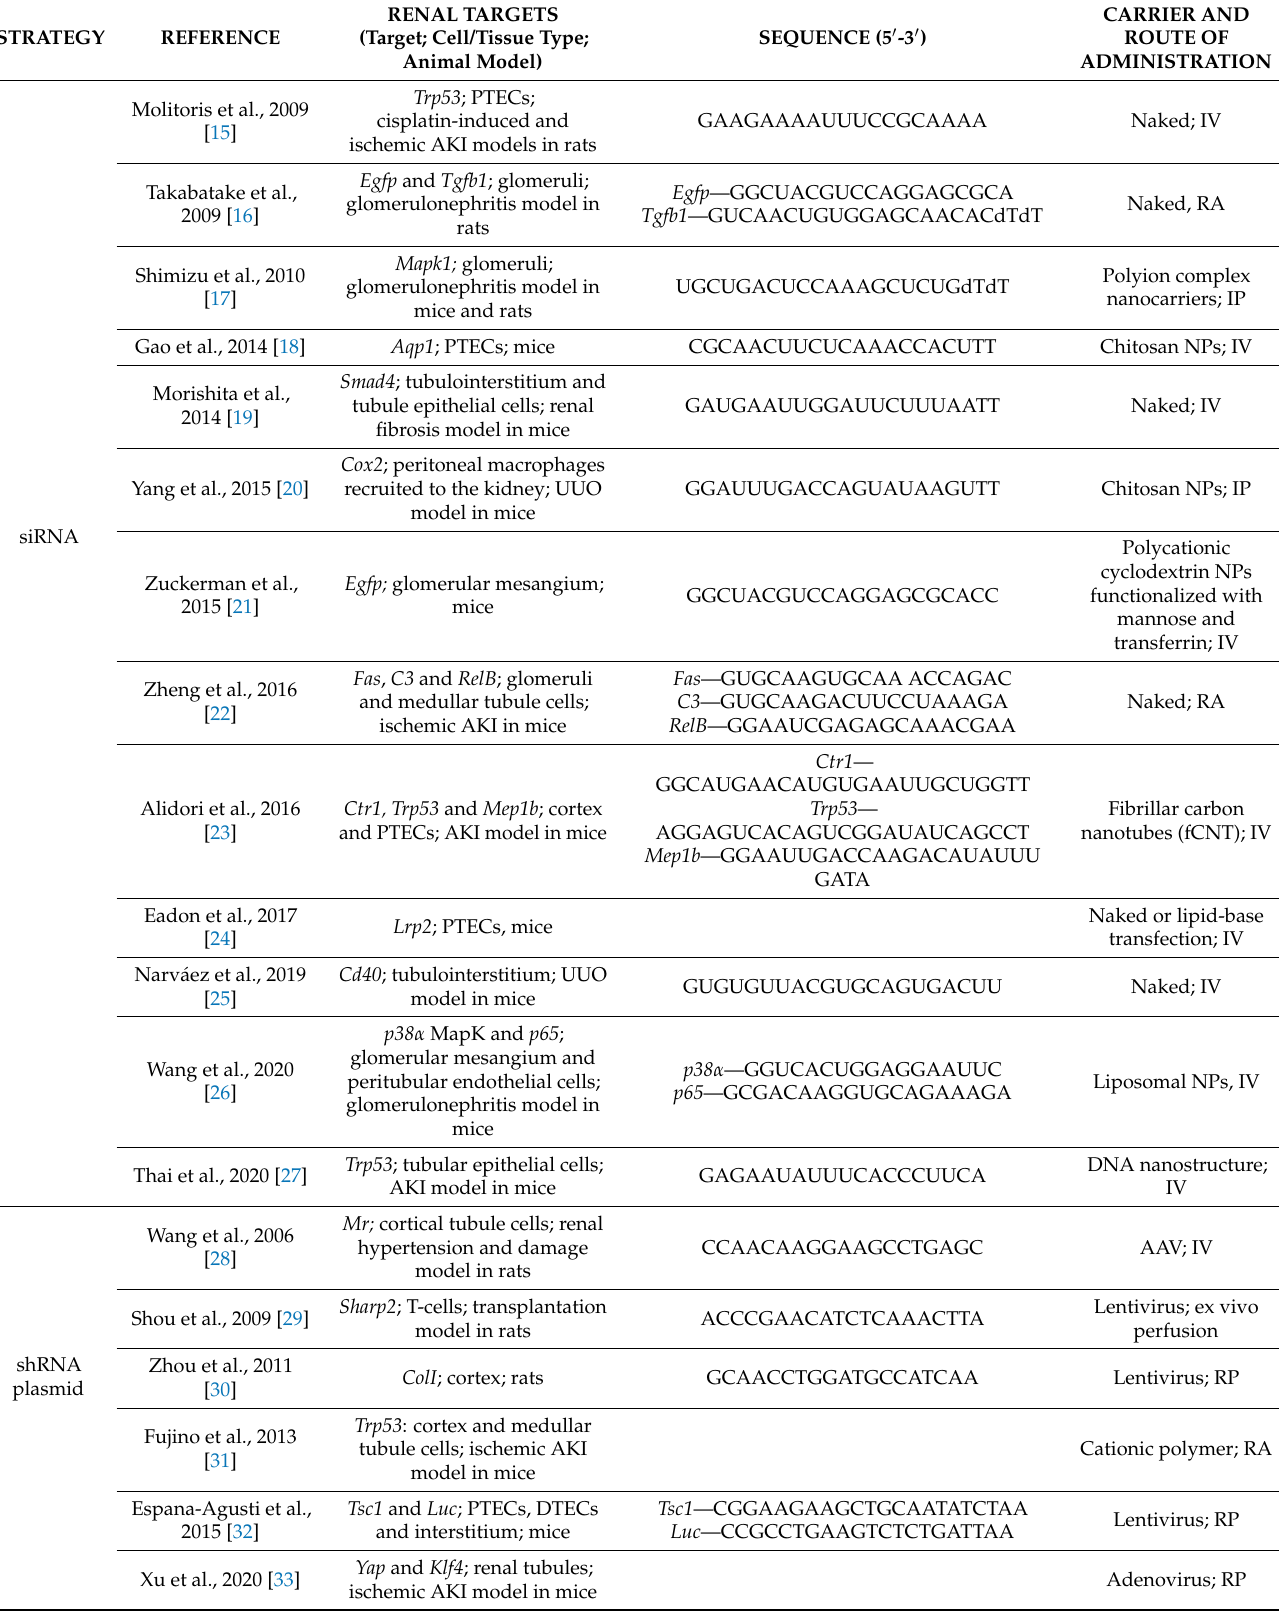
Table 1. Summary of preclinical studies targeting the kidney with oligonucleotide-based therapies.